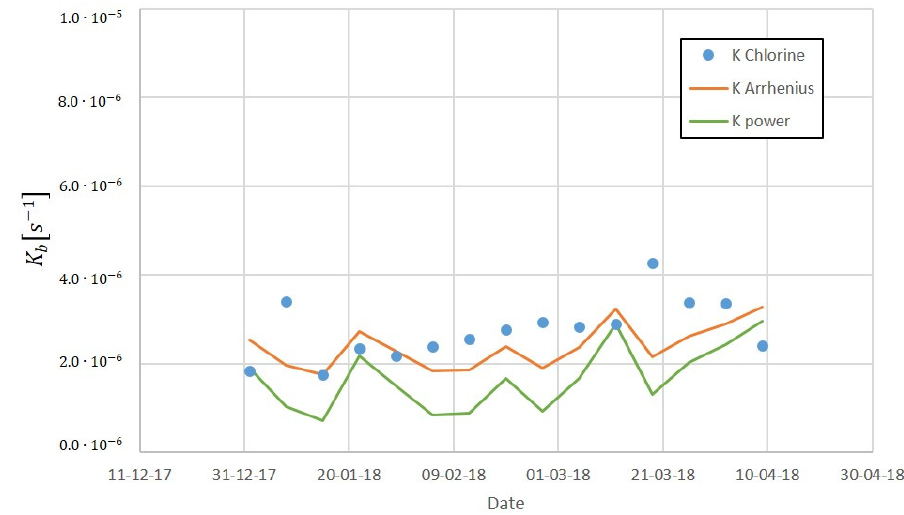
Figure 12. Chlorine decay constant forecast for the first days of 2018.